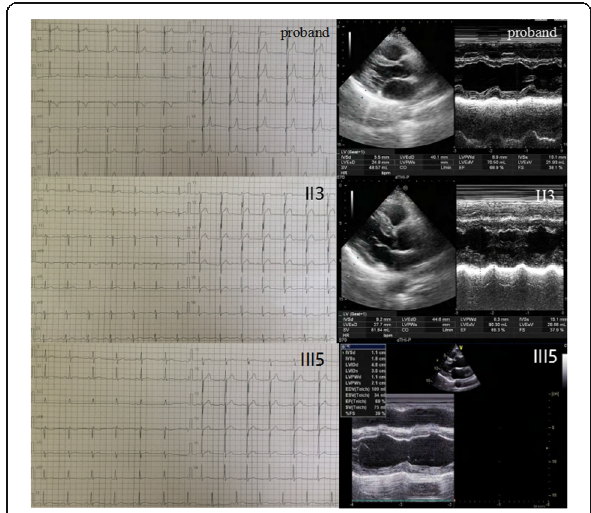
Fig. 5 The ECG and Echo of proband 、 II:3and III:5. Clinical cardiac evaluation showed no